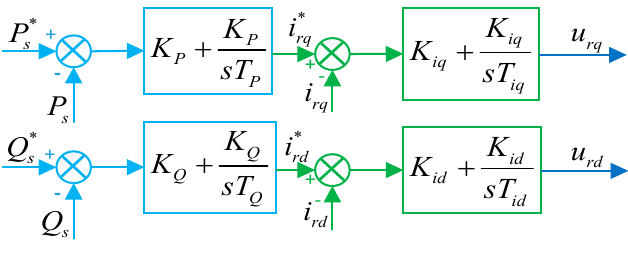
Figure 4. Control structure of PI scheme.